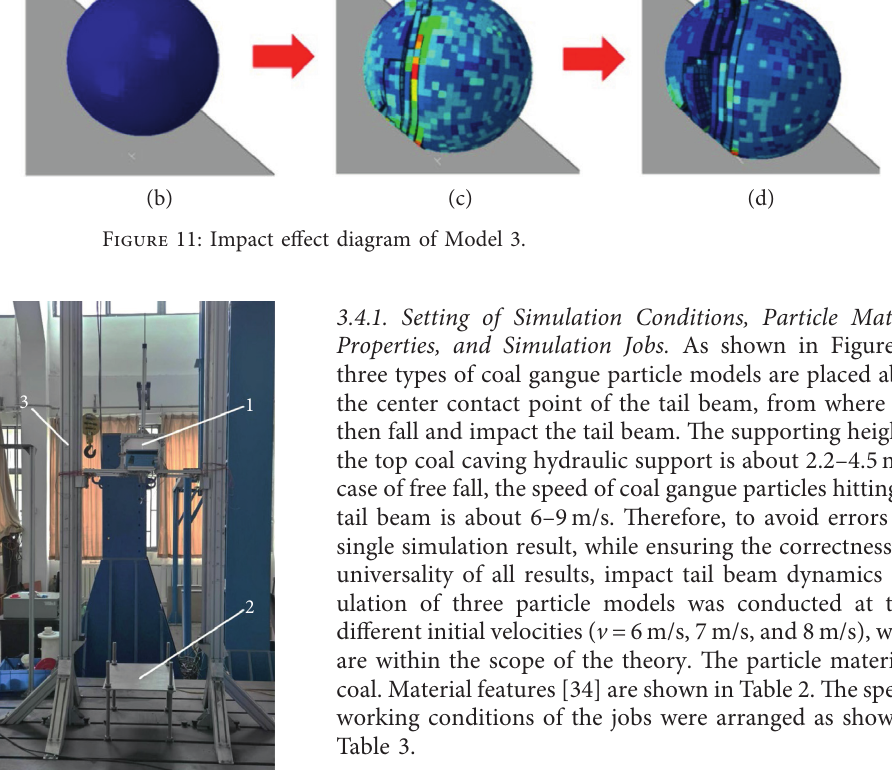
Figure 12: Single particle impact test